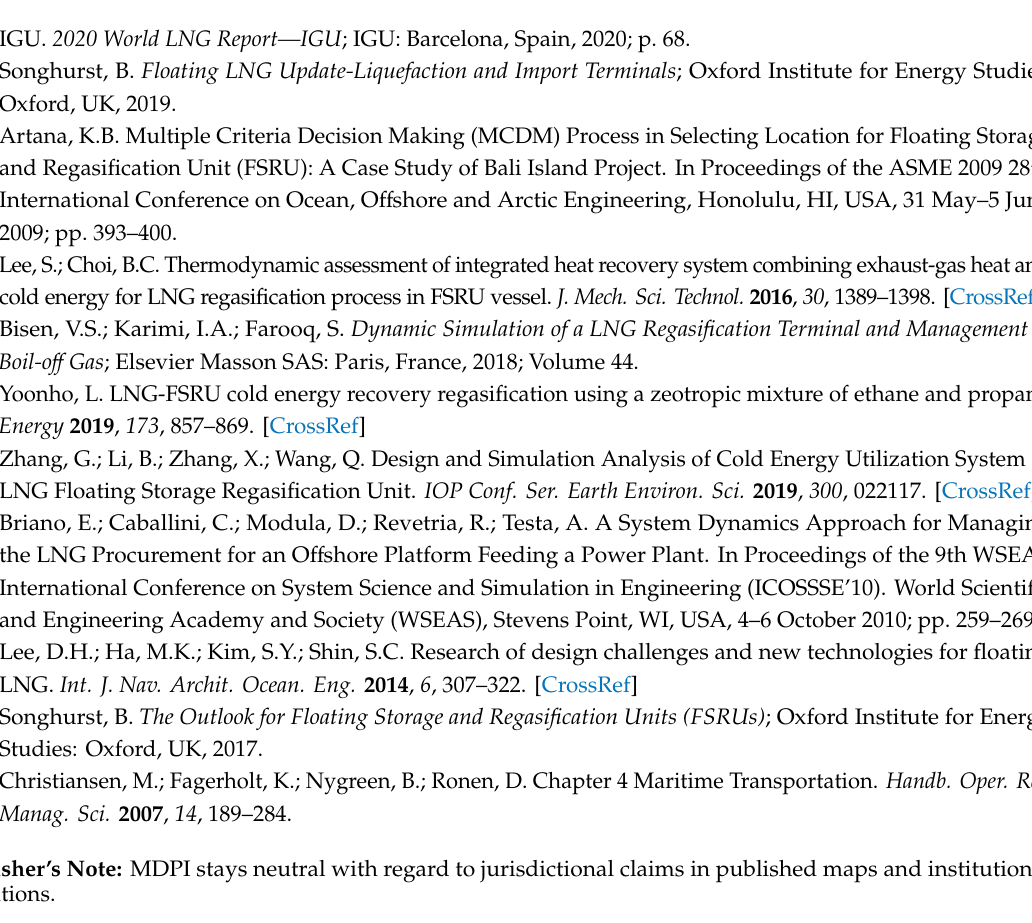
Figure A2. A schematic of the FSRU components used during discharging (authors’ illustration based on relevant technical manuals).